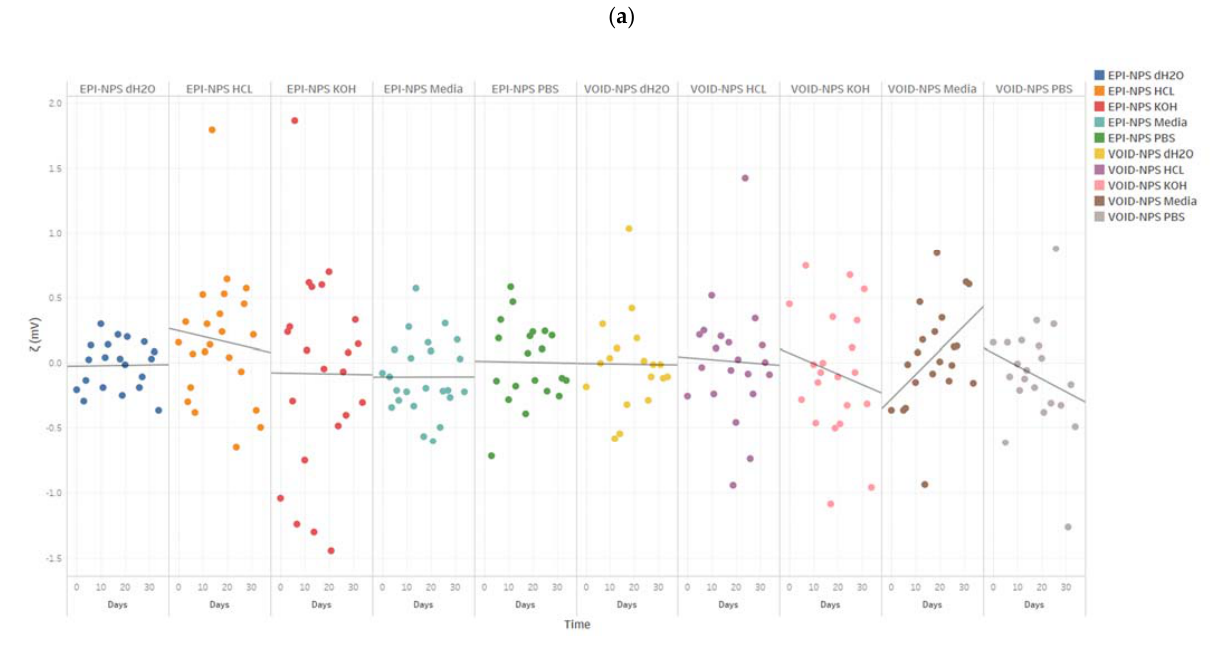
Figure 3. Mean ( a ) particle diameter, ( b ) polydispersity index and ( c ) zeta-potential for epirubicin-loaded NPs and void NPs. The data represent the mean average of the five instrument runs for each sample.